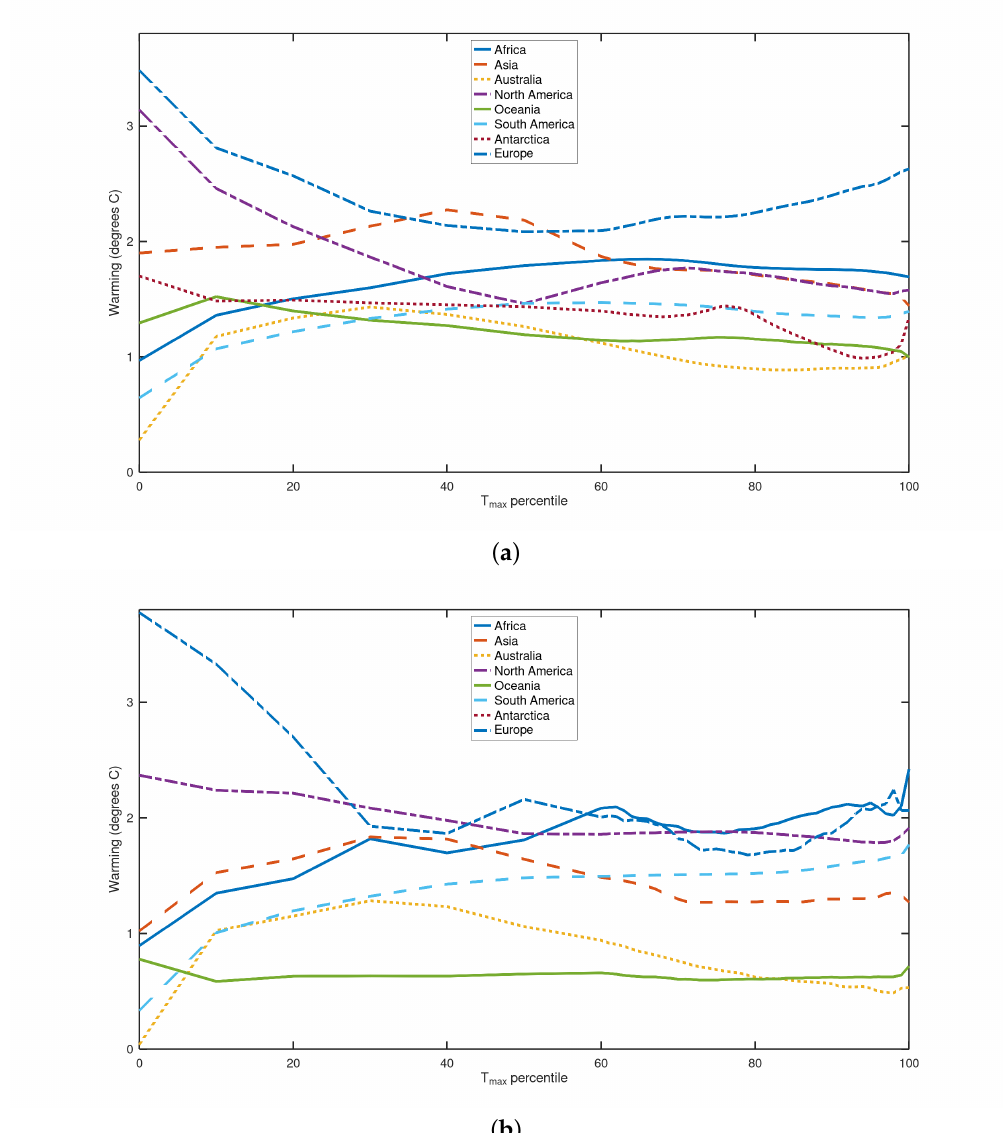
Figure 3. ( a ) Smoothed ERA5 change in different percentiles of T max , 1959–2021, by continent (area-weighted average), showing every 10th percentile up to the 60th, then every percentile. The 0th percentile corresponds to the coldest T max of each year and the 100th percentile to the annual maximum temperature TXx. ( b ) Same, but using population-weighted